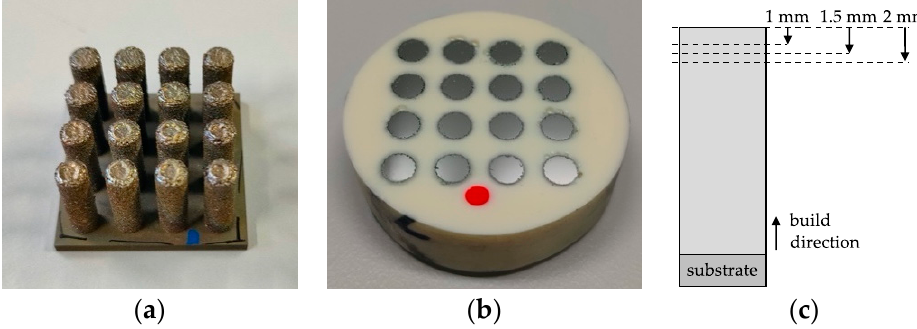
Figure 2. Samples (diameter: 5 mm) ( a ) as-printed, ( b ) after preparation, ( c ) position of prepared sections. Images of the whole samples were taken with a Zeiss AxioImager microscope with Zeiss ZenCore software at a 10 × magnification (pixel size: 0.56 µ m) in stitching